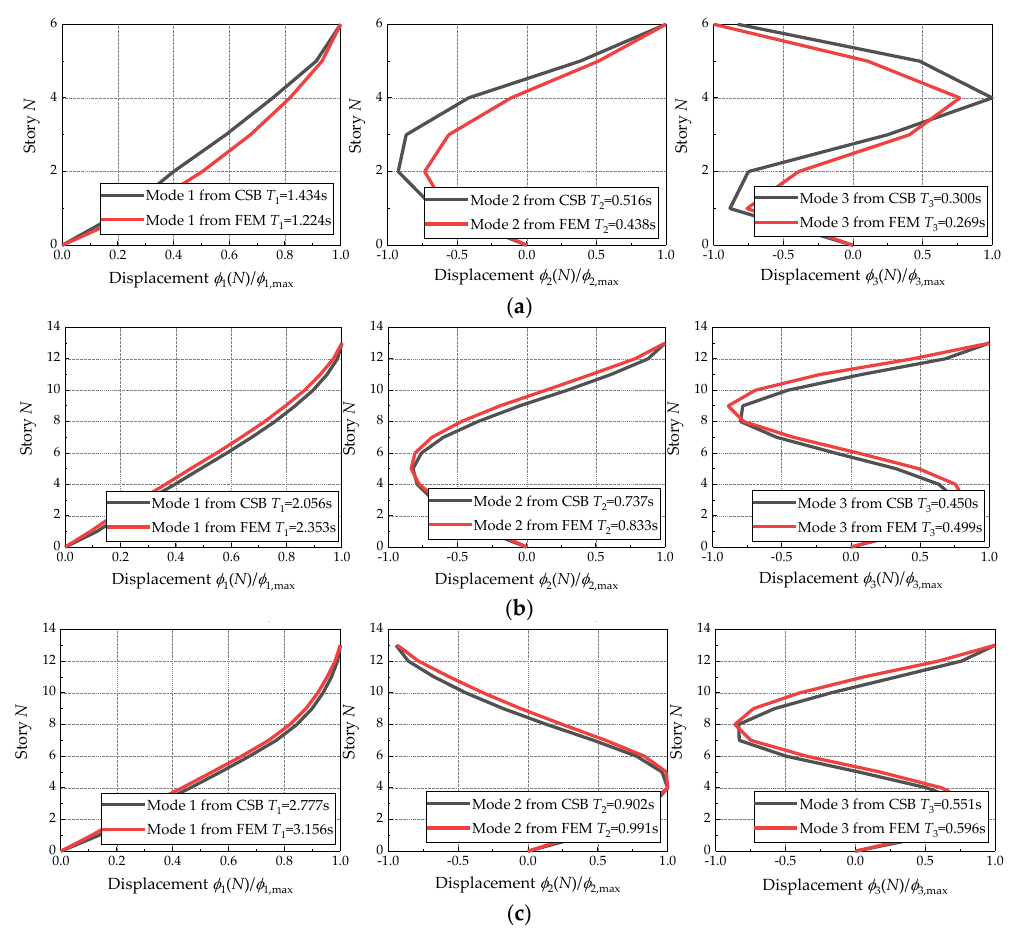
Figure 12. Comparison of dynamic features. ( a ) Comparison of dynamic features for 6F. ( b ) Comparison of dynamic features for 13F. ( c ) Comparison of dynamic features for 13F-W.